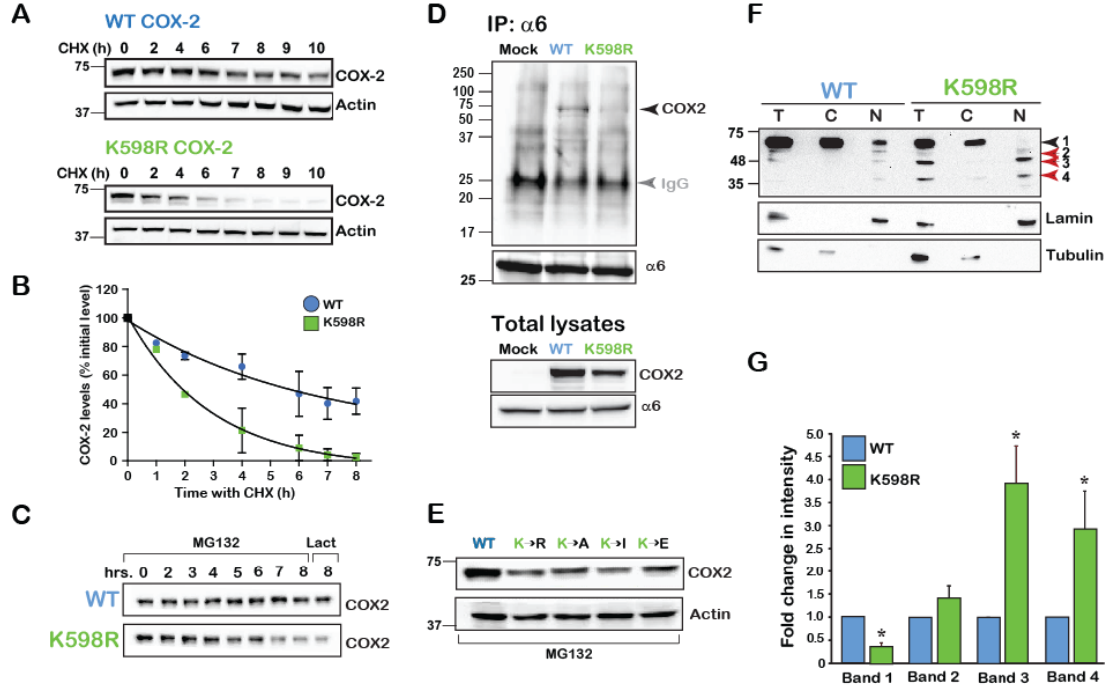
Figure 2. K598 COX-2 presents a fragmented pattern. ( A ) A representative immunoblot of HEK 293 cells transfected with 0.5 µg of either WT or K598R COX-2 for 16 h. Degradation of the native form (~72 kD) was studied following application of 50 µM of cycloheximide (CHX) for the indicated times. ( B ) Summary graph of n = 3 independent experiments depicting the decay in the levels of full-length WT and K598R COX-2. Quantification was done by comparing the levels of COX-2 over time as